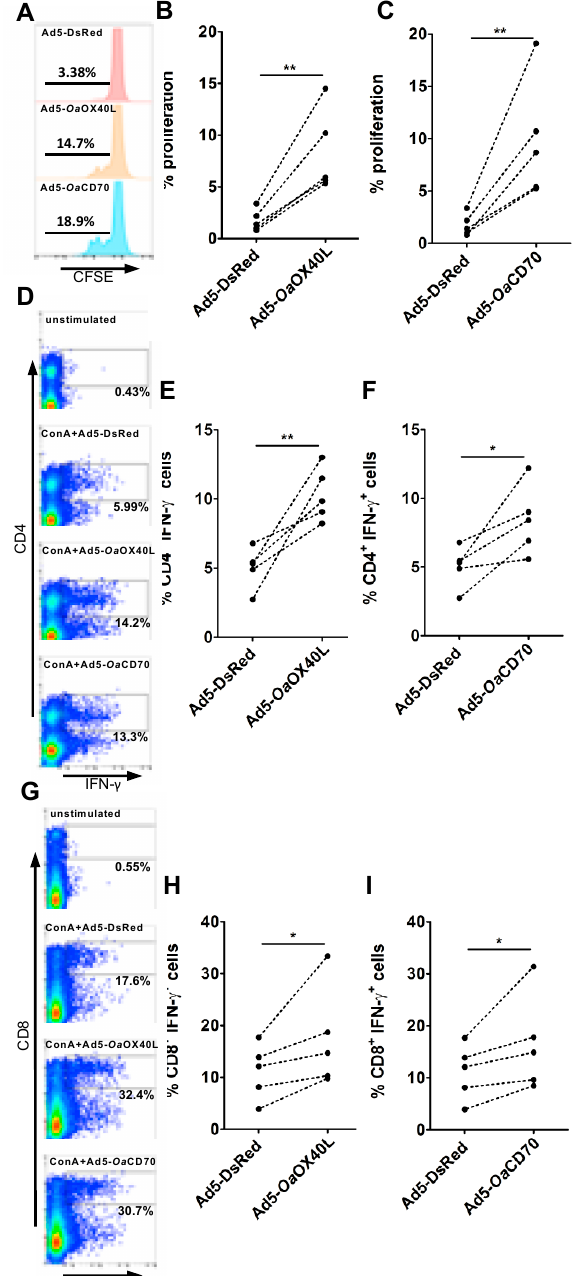
Figure 8. The r Oa OX40L and r Oa CD70 ligands promote sheep T cell proliferation and IFN- γ production. ( A – C ) An enriched T cell fraction was obtained from sheep ( n = 5) PBMCs, labelled with CFSE and cultured for 4 days with equivalent amounts of conditioned media from Ad5- Oa OX40L-, Ad5- Oa